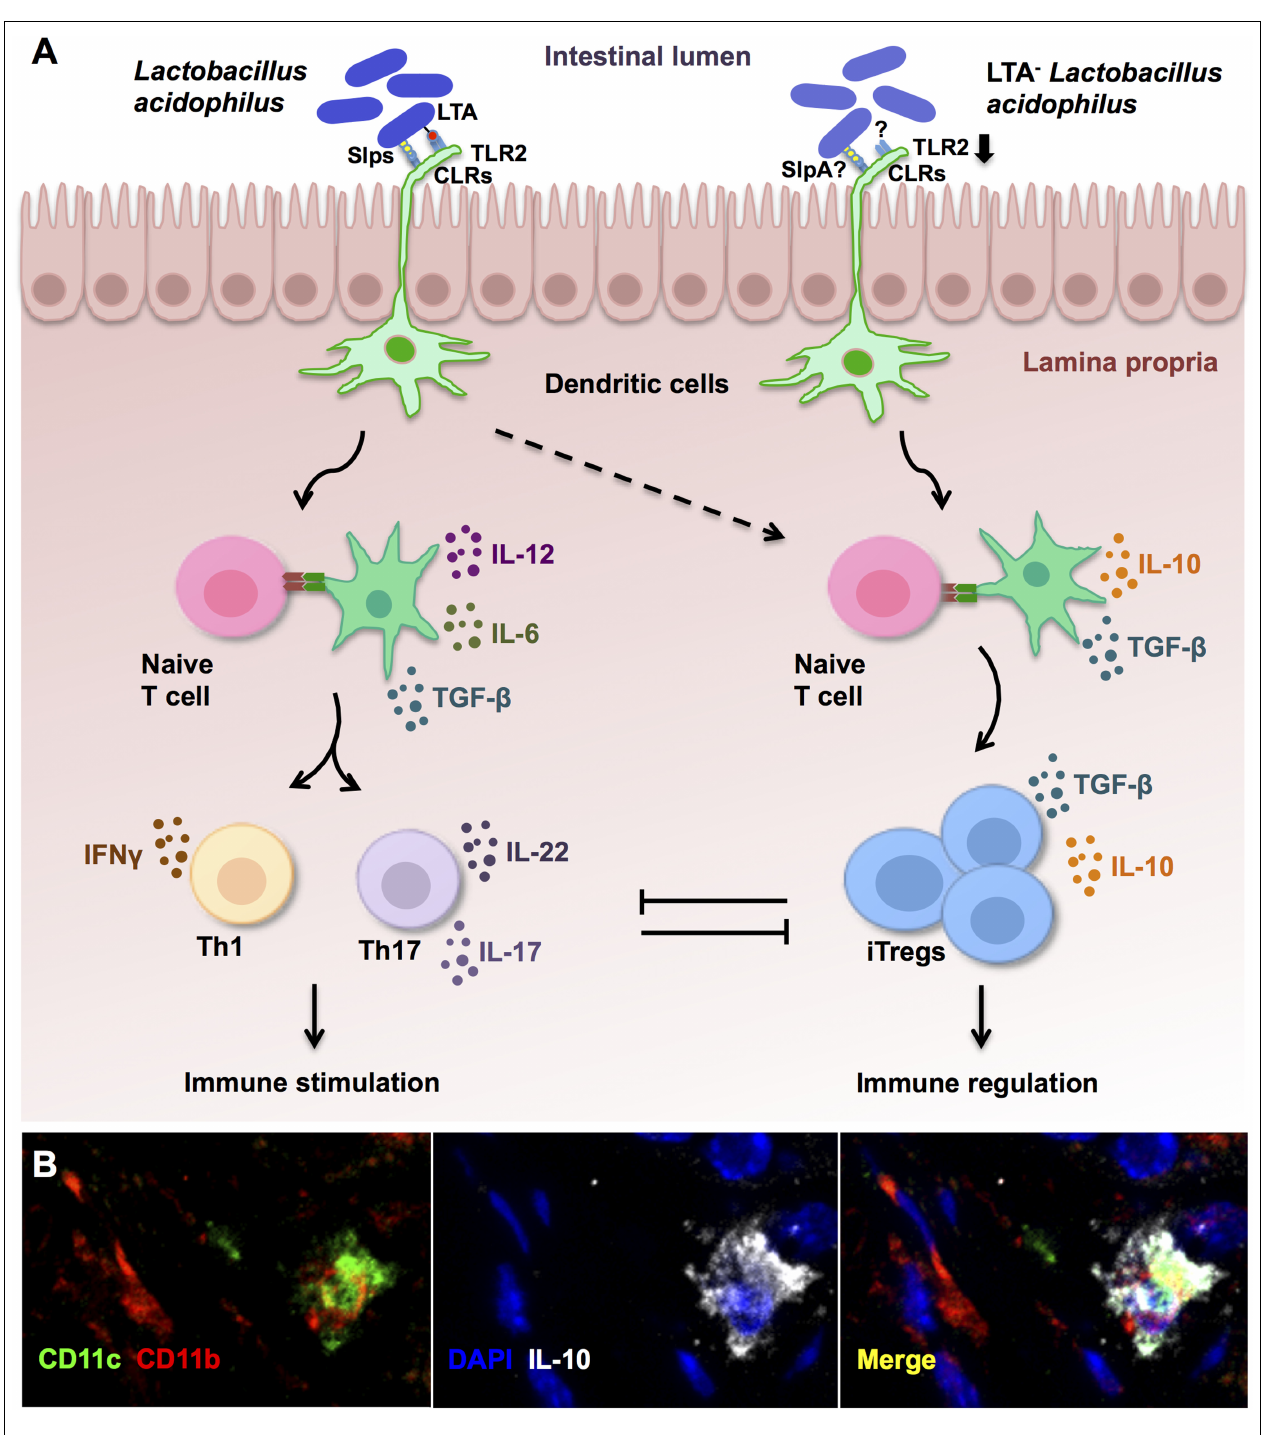
FIGURE 1 | Immune regulation established by lipoteichoic acid (LTA)-deficient Lactobacillus acidophilus . (A) In steady state conditions, molecules expressed on the cell surface of L. acidophilus activate dendritic cells (DCs) to promote effectorTh1 andTh17 responses that are held in check by the accompanying generation of induced regulatoryT cells (iTregs). However, in preexisting inflammation or susceptible individuals, immune activation by L. acidophilus -LTA exacerbates inflammatory responses and fails